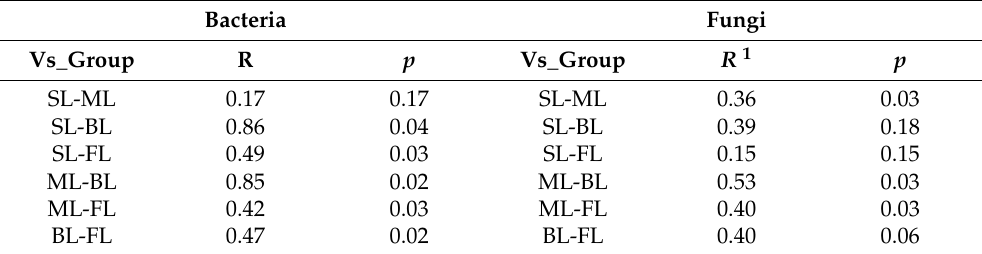
Figure 5. NMDS ( A , B ) and boxplot of Shannon diversity index ( C , D ) of bacterial and fungal communities in different land-use types. Different letters above boxplots indicate significant differences among land-use types ( p < 0.05) based on one-way ANOVA with the LSD test. Abbreviations: FL, forest land; SL, sugarcane land; ML, maize land; BL, barren land. Table 1. Analysis of similarities among soil bacterial (left) and fungal (right) community composition in four land uses based on 999 permutations.